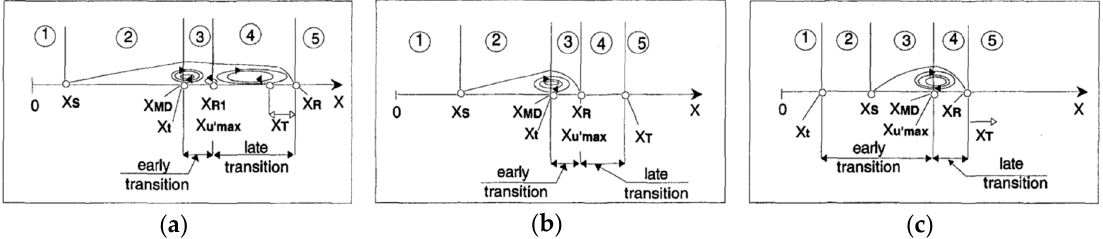
Figure 12. The separation bubble modes: ( a ) the laminar separation/long bubble mode; ( b ) the laminar separation/short bubble mode; ( c ) the transitional separation mode.